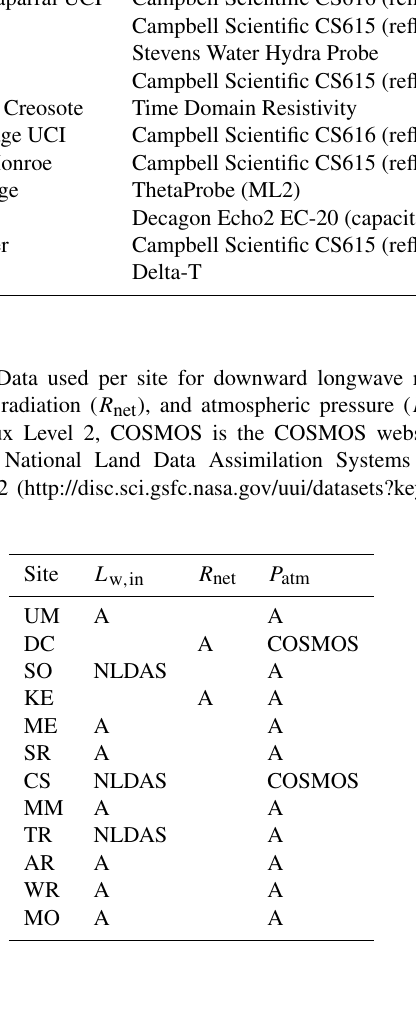
Table A1. PS types, installation depths, and number of profiles. The last column shows to which JULES layer the observations were lin- early interpolated.